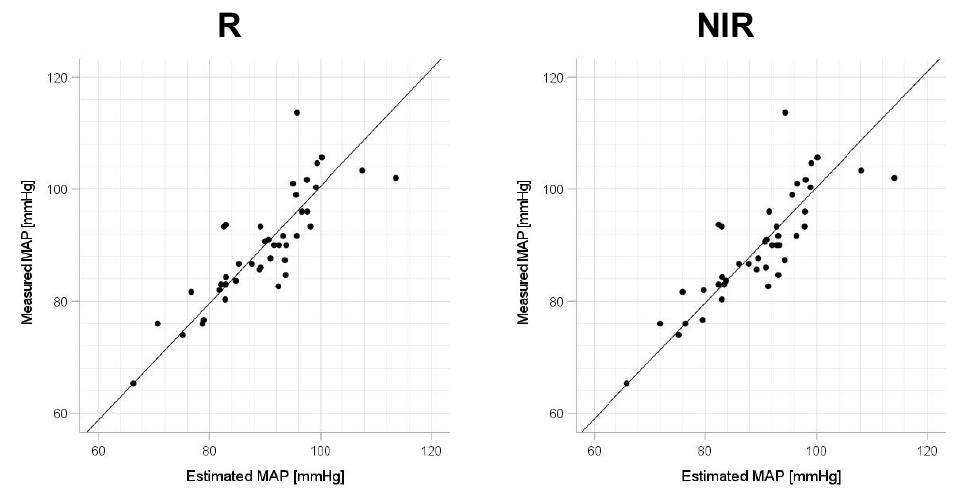
Figure 8. Accuracy of mean arterial pressure (MAP) estimation at each wavelength. Scatterplots of MAP estimated using proposed method and MAP measured with a cuff sphygmomanometer ( N = 42). From left to right, the light source wavelengths are blue (B), green (G), red (R), and near-infrared (NIR). The solid line on each scatterplot is the regression line with geometric mean regression.